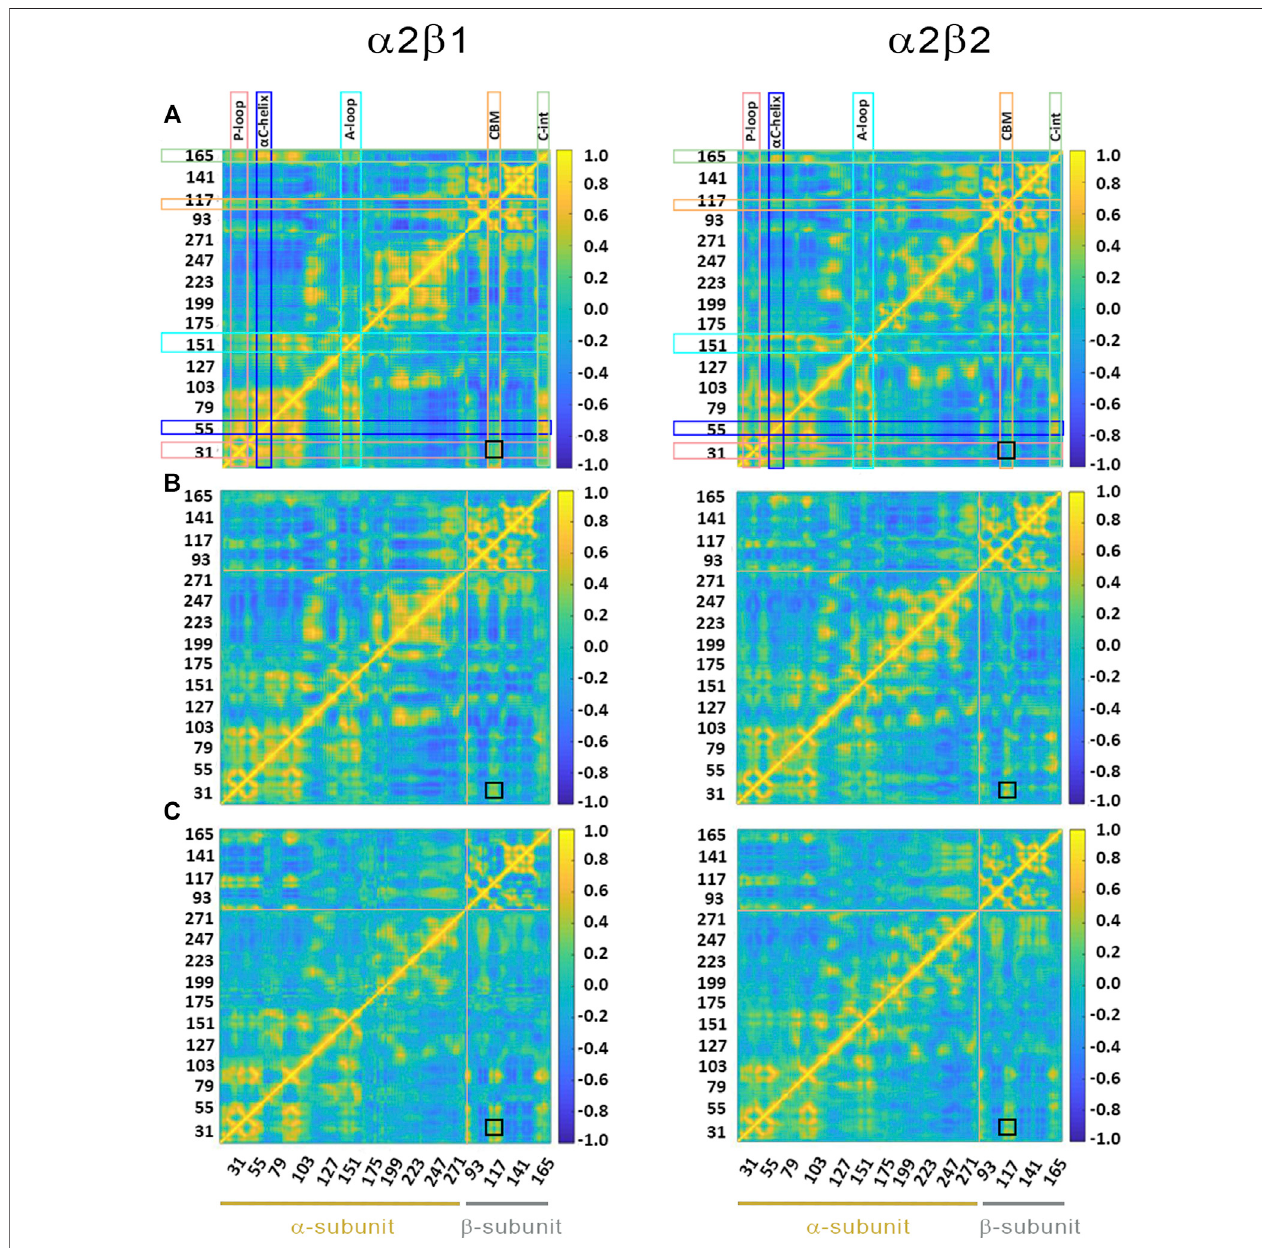
FIGURE 6 | Dynamic cross-correlation (DCC) matrices for (A) apo, (B) holo and (C) holo+ATP complexes of (left) α 2 β 1 and (right) α 2 β 2 with PF-739. The x - and y -axis denote the numbering of residue in the α - and β -subunit, indicated at the bottom of the plot (yellow and gray lines for α - and β - subunits, respectively). Speci fi c regions of AMPK are highlighted with squares at the top of the plot: P-loop (pink) , α C-helix (blue) , activation loop (A-loop; cyan ), CBM unit (orange) and C-interacting helix(C-int; green ).Regionscoloredinyellow/blueshowhighcorrelated/anticorrelated fl uctuations.Theblacksquareintheplotshighlightsthemotionbetweenthe CBM domain and the